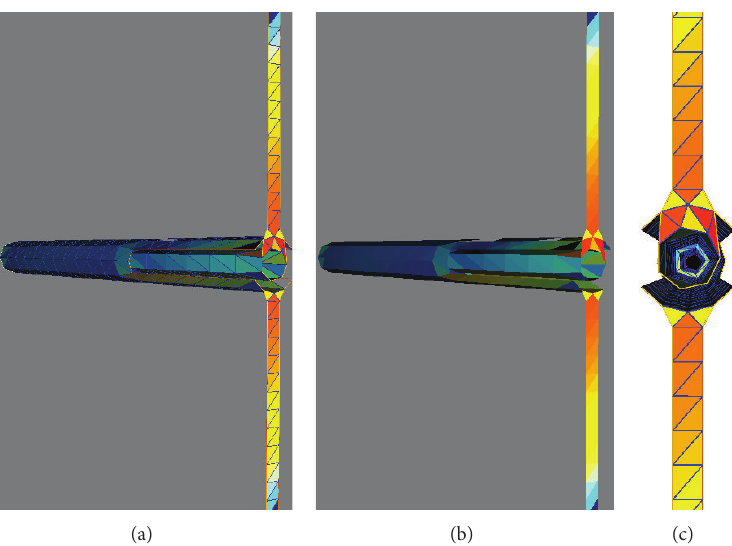
Figure 13: The current distribution on the dipole arms fed through a split coaxial balun with a step transition in the inner diameter conductor on the surface model of the balun and dipole (a) showing the sides of the triangular patches and (b) hiding the sides of the triangular patches, and (c) zoom-in view at the antenna connection with the balun; 𝑓 = 2 GHz.